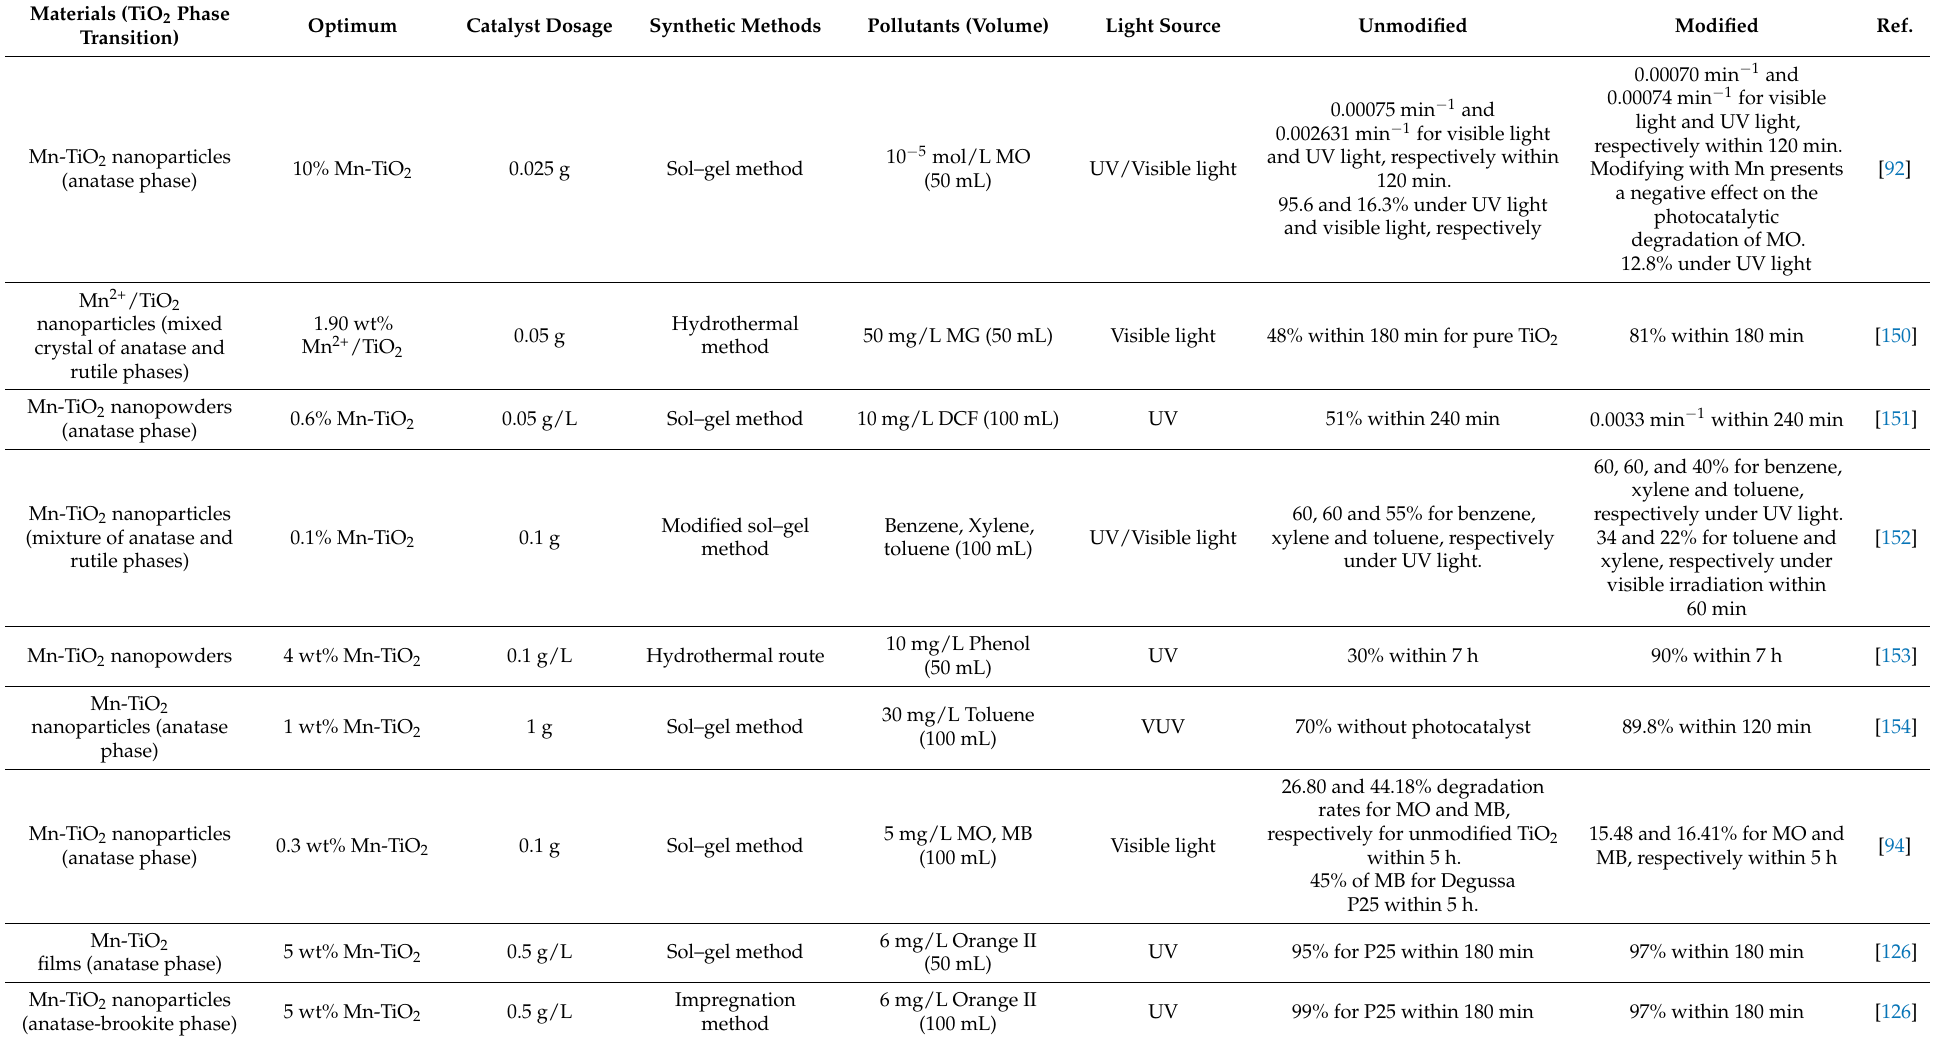
Table 6. Summary of recent progress on Mn-TiO 2 photocatalysts for organic pollutants